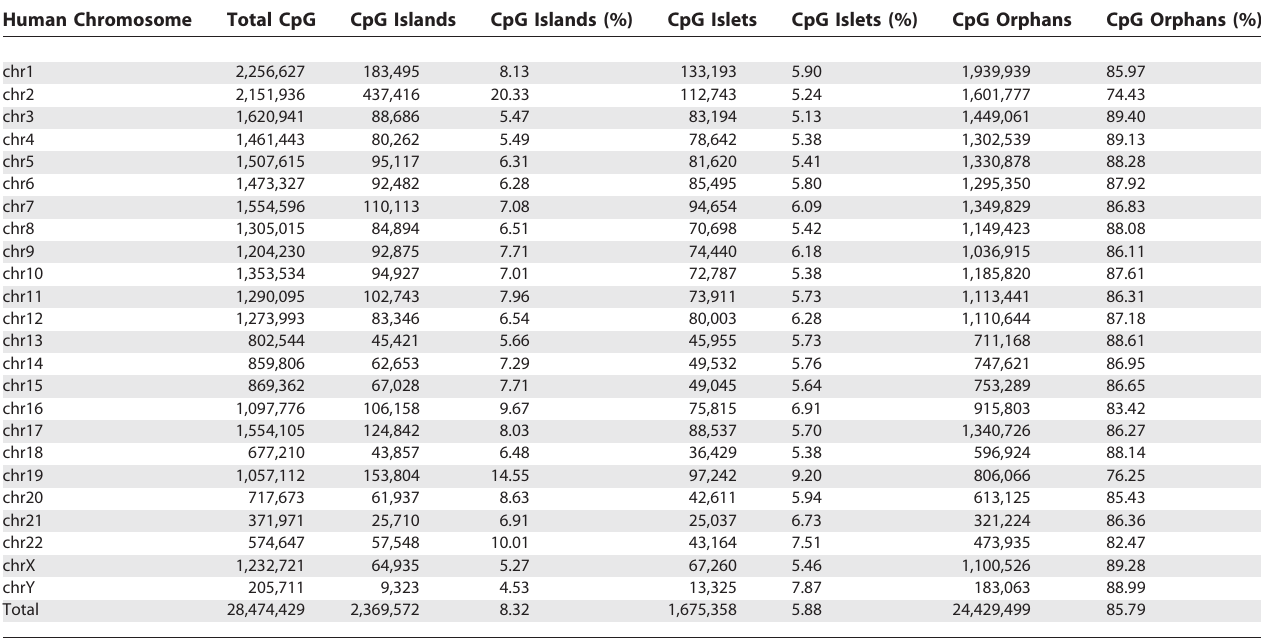
Table 3. Genome-Wide Distribution of CG Dinucleotides within CpG Islands as Defined by [15], and within CpG Islets and CpG Orphans as Defined in This Study Human Chromosome Total